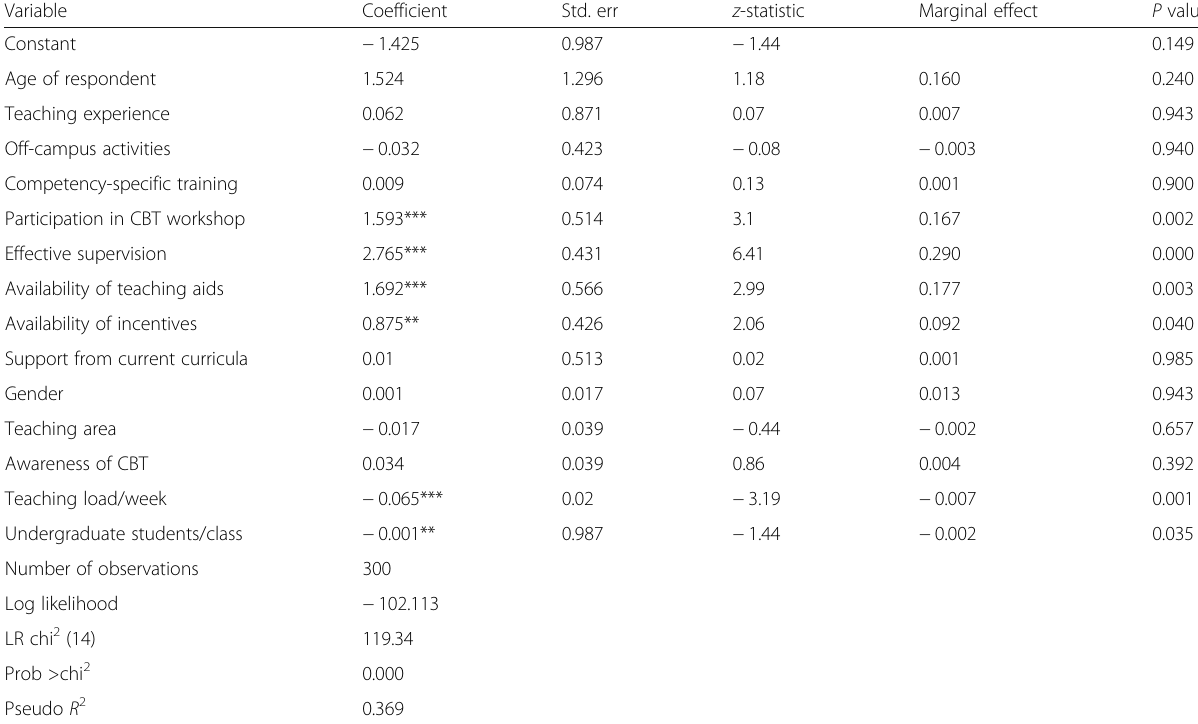
Table 5 Logistic regression coefficients and marginal effects of factors influencing adoption of CBT Variable Coefficient Std. err z